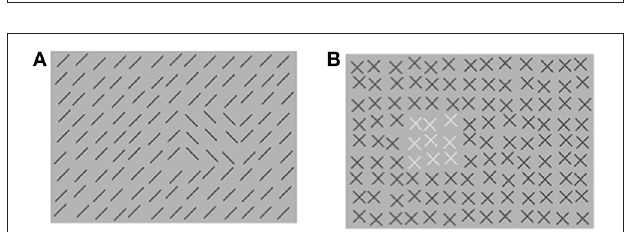
FIGURE 8 | Experiment 3: (A) stimulus texture with orientation-defined target. (B) Mask texture with luminance-defined patch. (A,B) The number of elements has been reduced for better visualization of the texture structure. For the same purpose the luminance-definedcontrast in panel (B) has been increased compared to the original